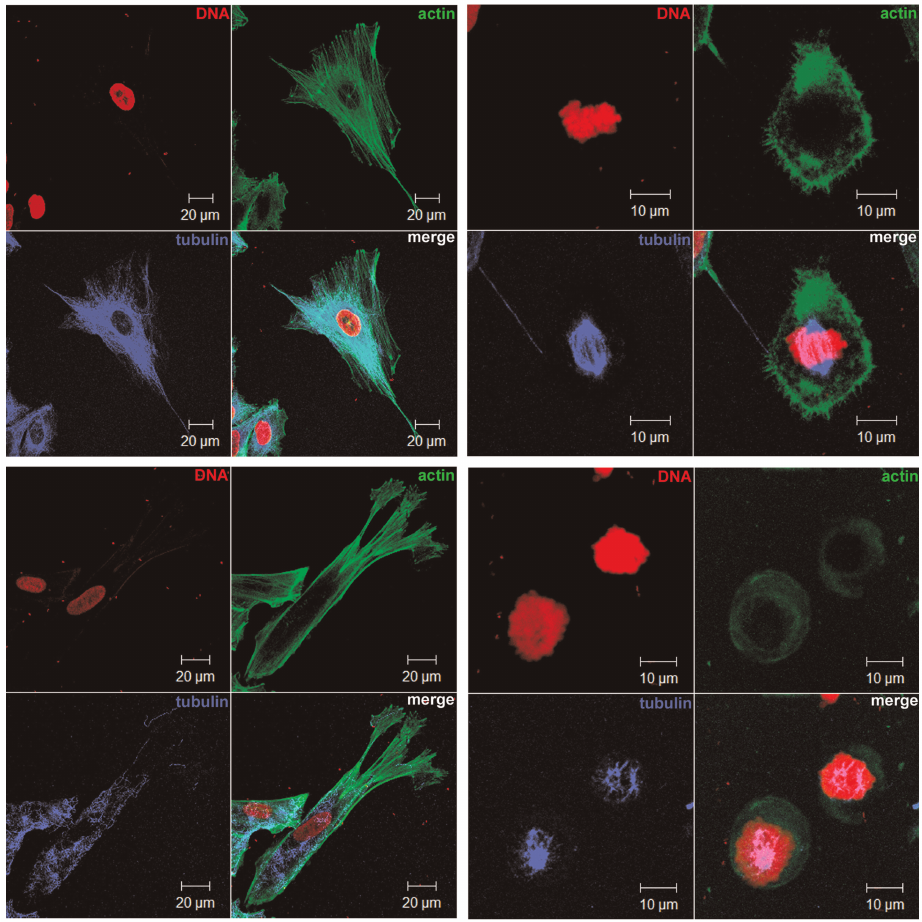
Figure 2. Cytoskeleton analyses in A549 cells submitted to double blockade. Upper panels show the integrity of microtubules and microfilaments of A549 cells in interphase ( upper left ) and in mitosis ( upper right ), in the control cells. Lower panels show A549 cells in T6 with microtubule network disorganization in interphase ( lower left ) and in c-mitosis ( lower right ) after treatment with vincristine. Images are projections of different slices obtained by laser scanning confocal microscopy and show microtubule in blue and microfilaments in green. Nuclei were counterstained with propidium iodide